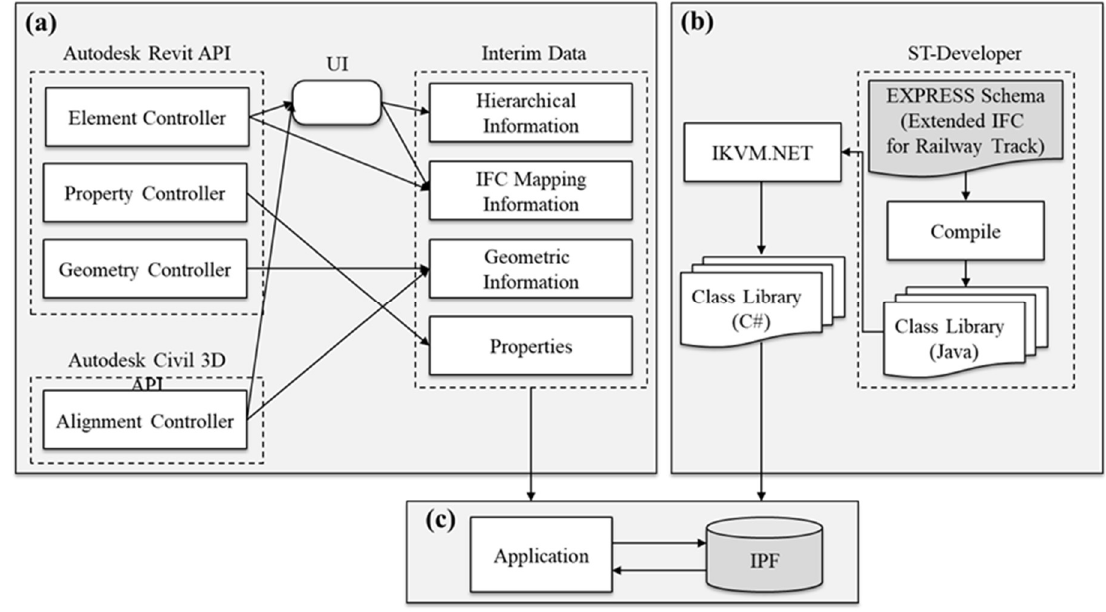
Figure 7. Extended IFC-based information modeling processes for alignment-based structures. Panels ( a )–( c ) illustrate different processes. API: application programming interface; IPF: IFC physical files; ST: STEP Tools; UI: user interface.